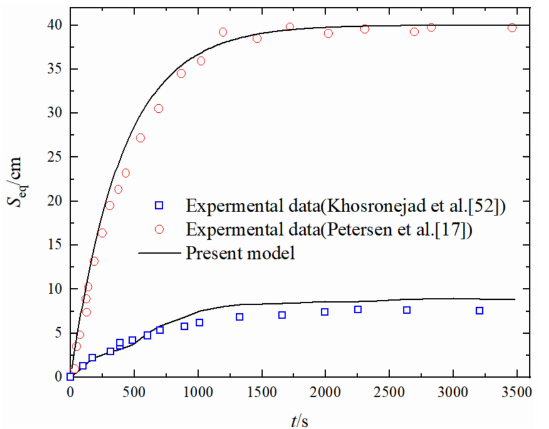
Figure 5. Comparison of time evolution of scour between the present study and Khosronejad et al. [52], Petersen et al.